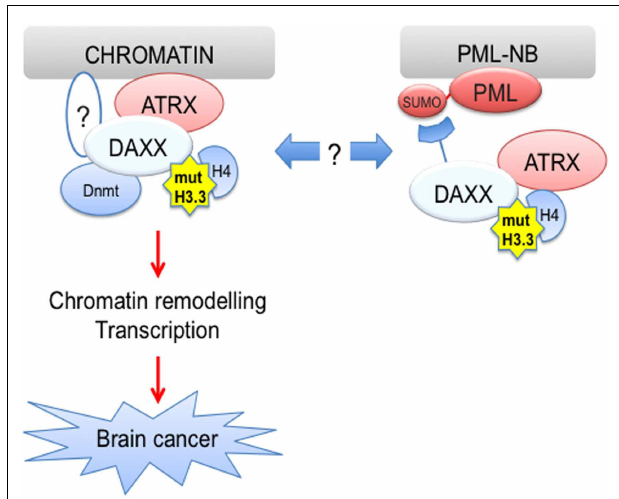
FIGURE 3 | H3.3 is mutated in human cancer . Driver H3.3 mutations are found in pediatric glioblastoma (pGBM), suggesting that alterations of H3.3 function may lead to brain cancer. It is possible that PML via its ability to recruit DAXX to PML-NBs could regulate loading of mutant H3.3 proteins, thus potentially affecting brain